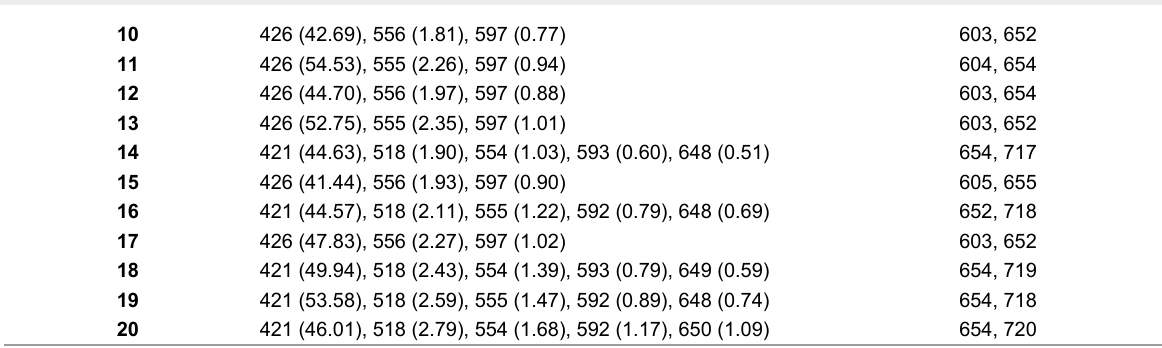
Table 1: Electronic absorption and emission data of porphyrins ( 2 – 20 ). (continued)